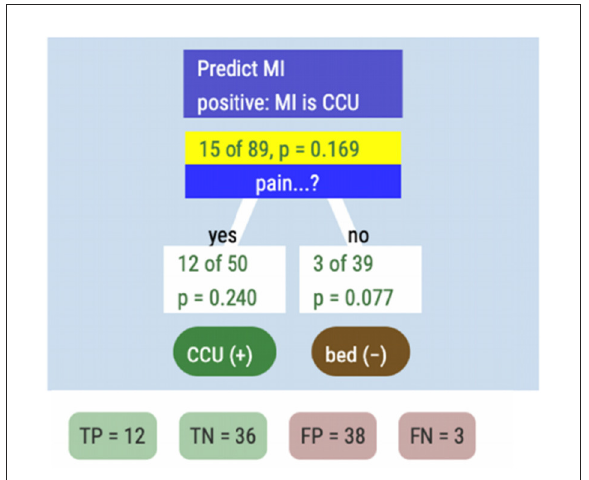
FIGURE9 The simplest possible tree.